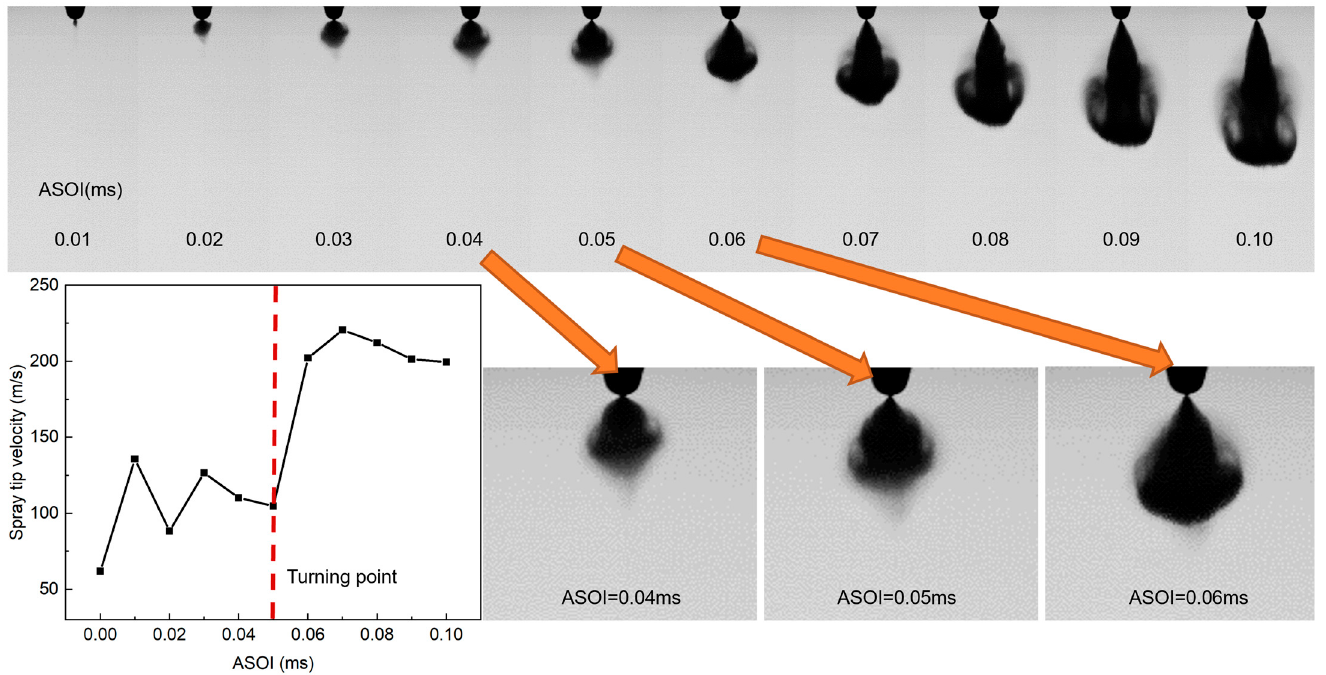
Figure 15. Near-nozzle spray structure, P amb = 0.1 MPa, P inj = 100 MPa; ambient gas: N 2.